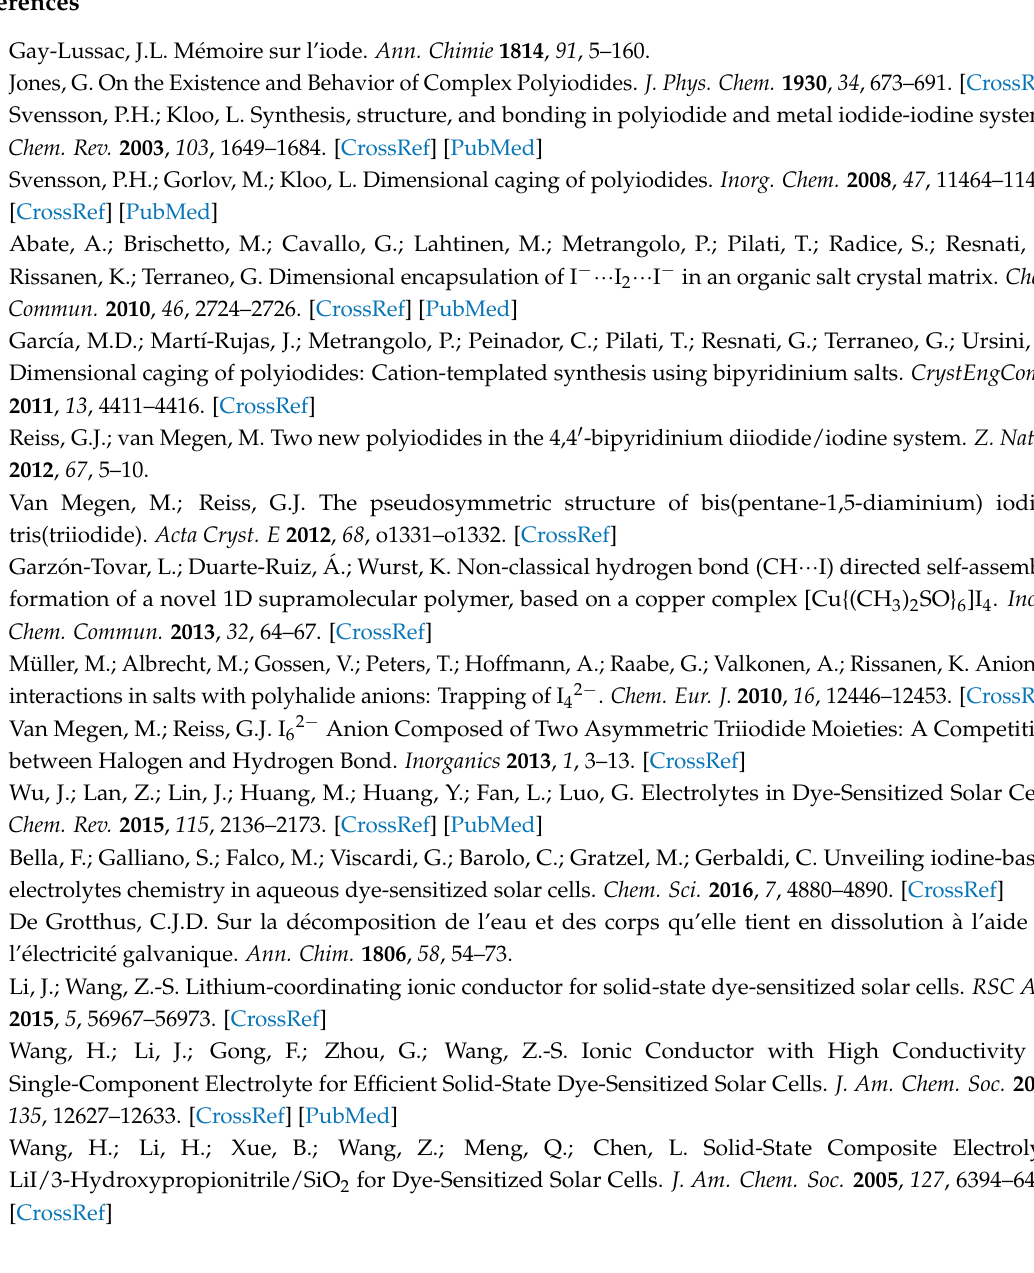
Table S1: Hydrogen bonds found in the [(H 2 L1) 2 I 2 (I 5 )(I 3 ) 3 ] crystal structure; Figures S1–S18: 1H-NMR, 13C-NMR and MS spectra of synthesized derivatives; CIF and checkCIF